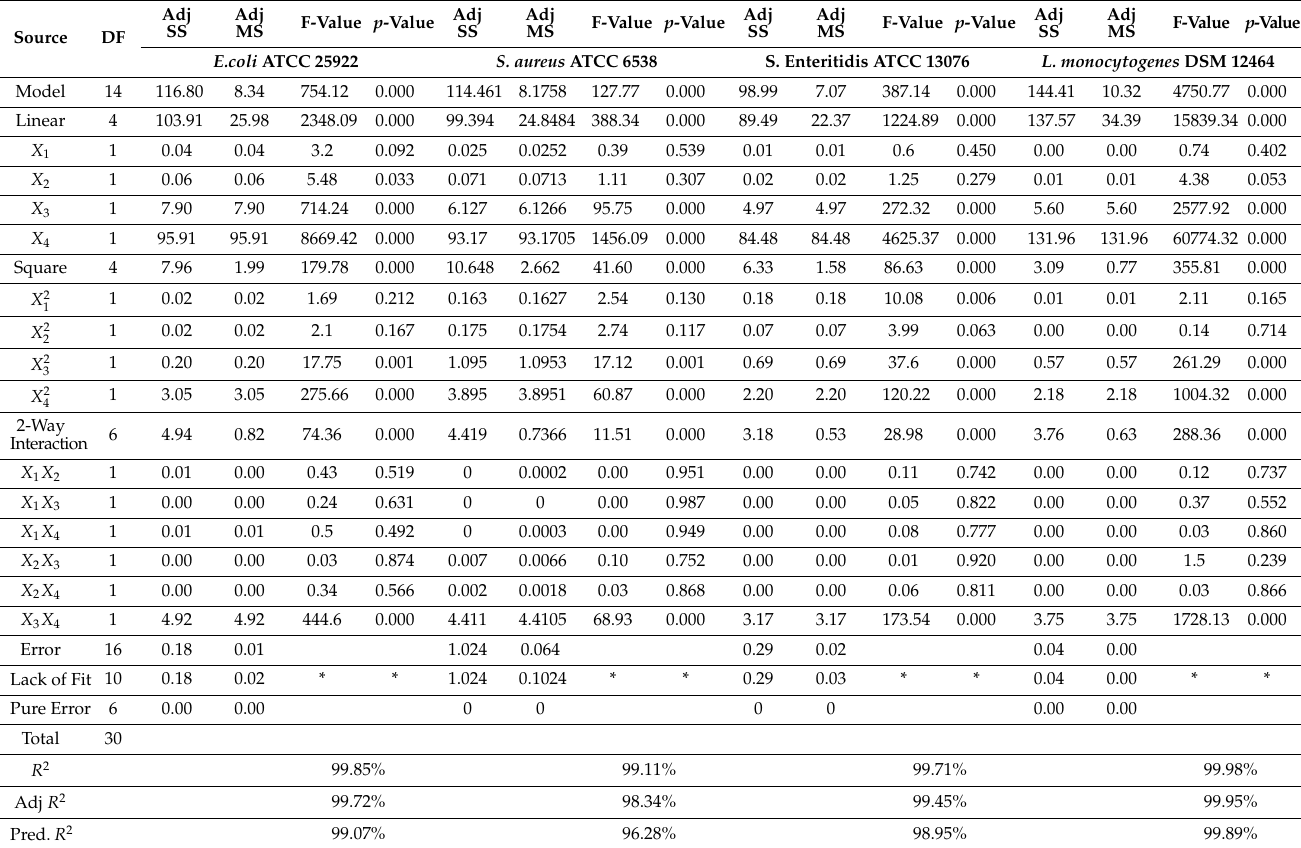
Table 3. Analysis of variance in a regression model of the central combination